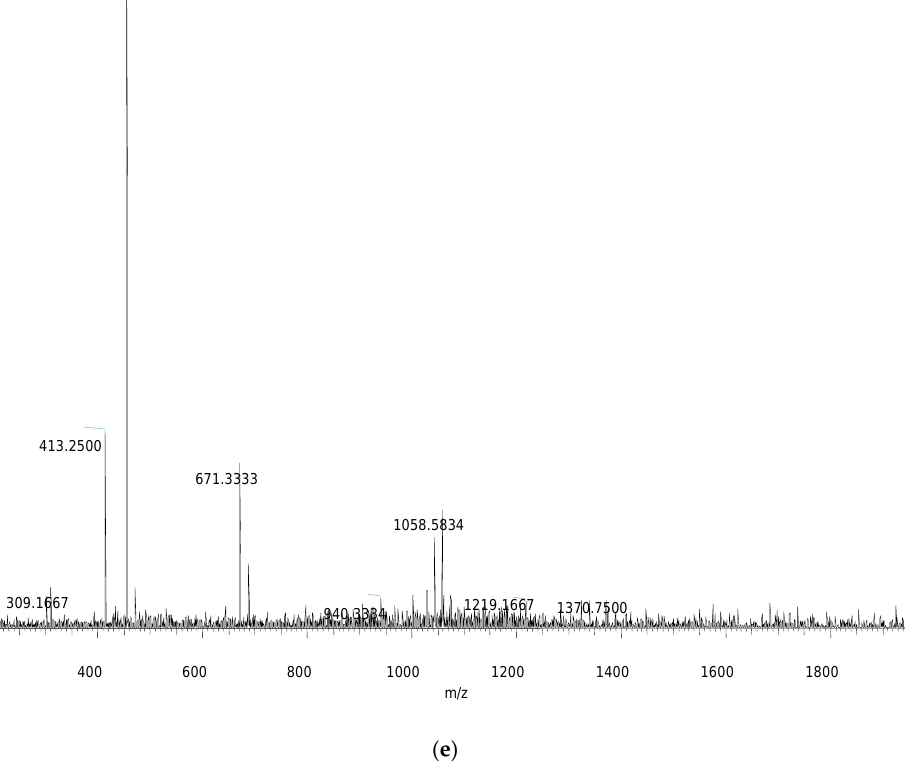
Figure A6. ( a ) 1 HNMR spectrum of compound 5 . ( b ) 13 CAPT spectrum of compound 5 . ( c ) HSQC spectrum of compound 5 . ( d ) HMBC spectrum of compound 5 . ( e ) ESIMS spectrum of compound 5 .